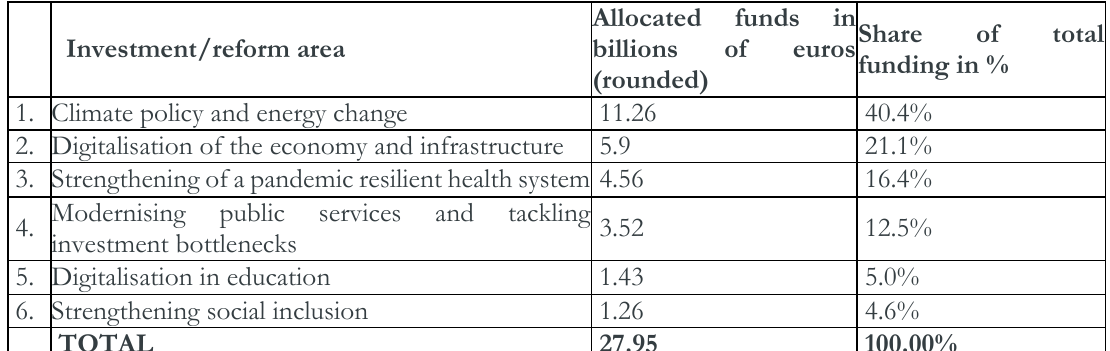
Table 1: Germany’s six policy areas for RRF funding